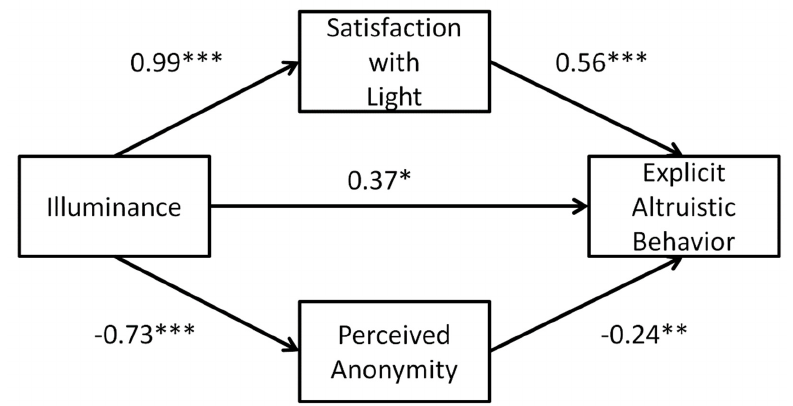
Figure 4. The mediation effects of satisfaction with light and perceived anonymity underlying the effect of illuminance on explicit altruism. Path values are the standardized path coefficients (* p < 0.05, ** p < 0.01, *** p < 0.001).